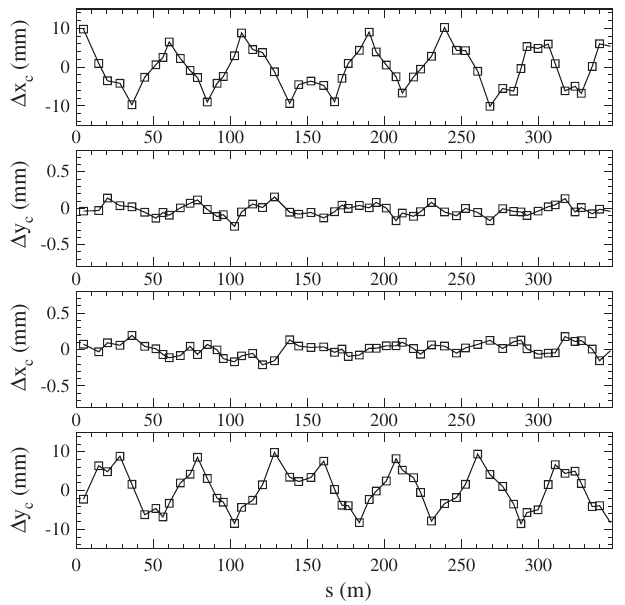
FIG. 11. Typical example of the horizontal and vertical closed orbit displacements ( (cid:1) x c and (cid:1) y c ) for 1 mrad horizontal single kick (upper two plots) and for 1 mrad vertical single kick (lower two plots), measured in the beam storage